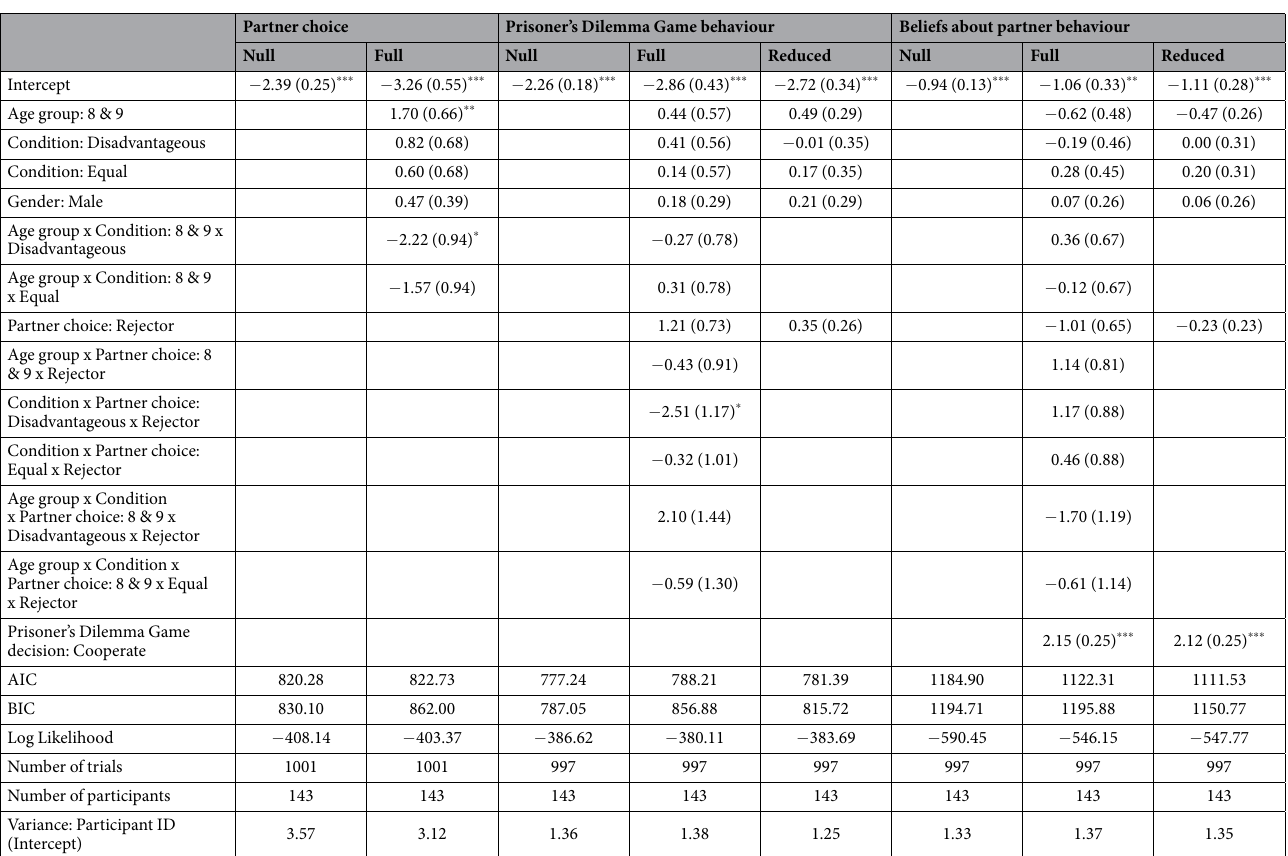
Table 2. Estimate and standard error (s.e.) of fixed effects in mixed models predicting participants’ partner choices, Prisoner’s Dilemma Game behaviour and beliefs about partner behaviour. In these models, age group was fit as a categorical predictor. Baselines for factors were: age group = 6- and 7-year-olds, condition =